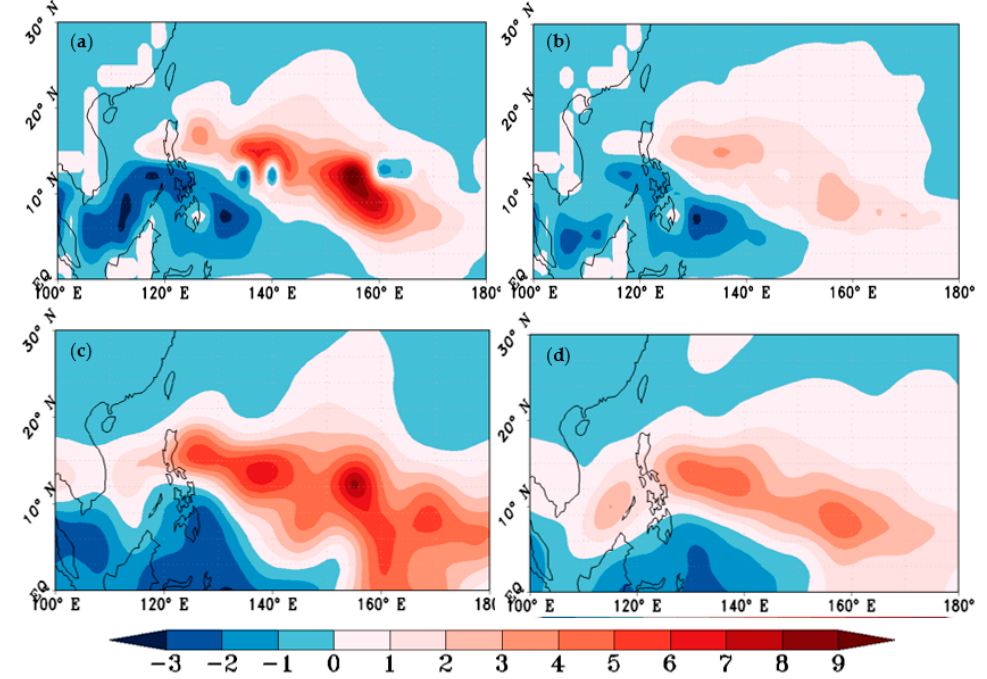
Figure 5. Anomalies in the WNP (including SCS) for ( a ) ENGPI in November 2019 compared to years with low TC frequency; ( b ) ENGPI in years with high TC frequency compared to the low TC frequency years; ( c ) DGPI in November 2019 compared to years with low TC frequency; and ( d ) DGPI in years with high TC frequency compared to the low TC frequency years.